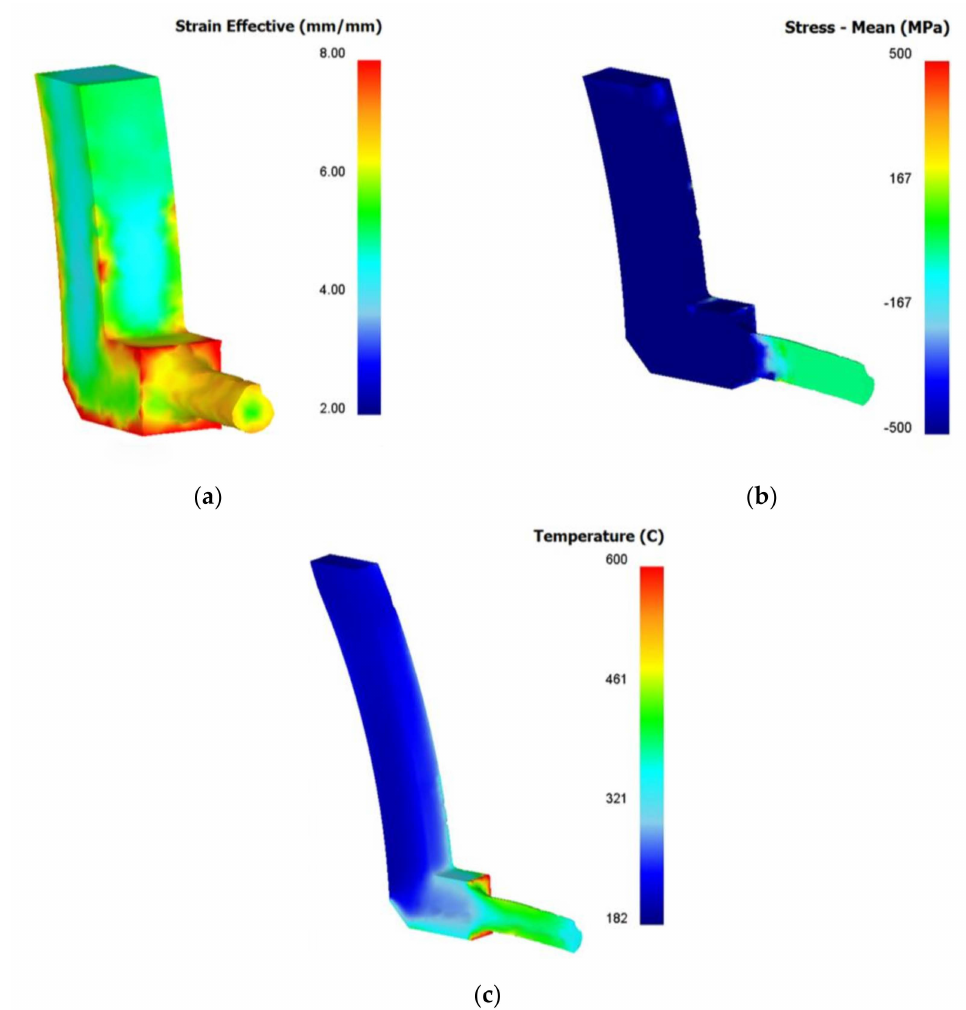
Figure 3. Computer simulation of Conform scheme (ECAP-C) with wire forming: ( a ) distribution fields of accumulated strain in the billet (cross-section), ( b ) mean stress fields in the deformation region (longitudinal section), and ( c ) temperature distribution fields (longitudinal